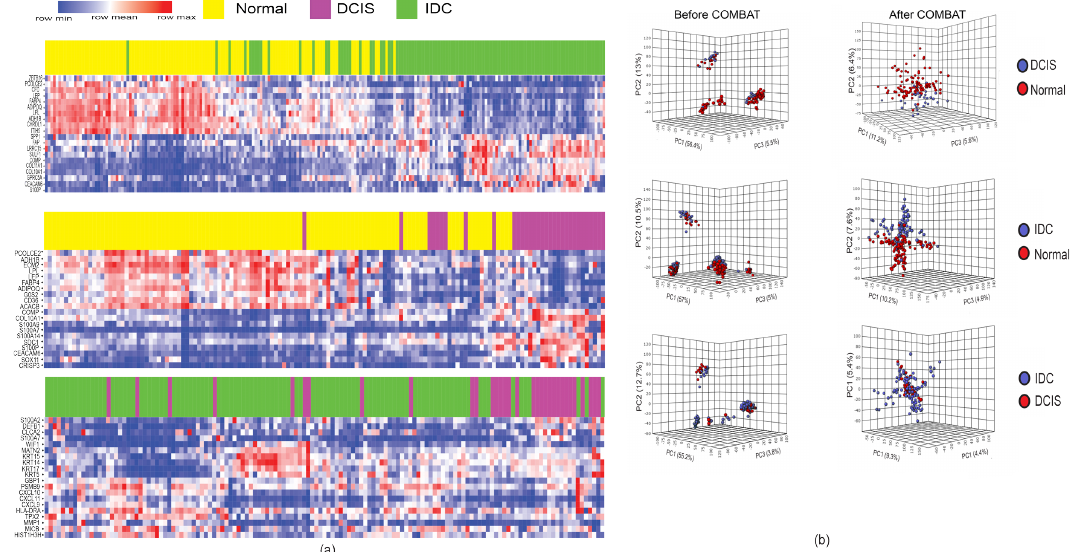
Figure 1. Unsupervised hierarchical clustering and PCA. ( a ) Two-dimensional heatmaps show 16 di ff erentially expressed genes based on the log fold-changes. Clustering was done after applying the ComBat method; ( b ) PCA analyses before (left) and after ComBat (right). PCA distinguished DCIS and IDC from normal samples based on their gene expression profiles, but failed to distinguish DCIS from IDC